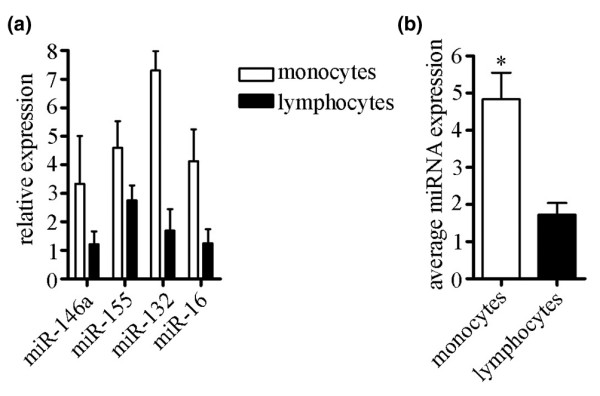
Monocyte/macrophage fraction of PBMCs exhibit increased miRNA expression compared with lymphocyte fraction. PBMCs were collected from RA patients and separated into monocyte/macrophage and lymphocyte populations by allowing the monocytes/macrophages to adhere to a tissue culture dish. (a) miRNA expression was examined using qRT-PCR. SEM is shown (n = 2 patients). (b) Average expression levels of miR-146a, miR-155, miR-132, and miR-16 are shown for monocyte and lymphocyte populations for two RA patients. *P < 0.02, as determined by Mann-Whitney test. SEM is shown. PBMC, peripheral blood mononuclear cell; qRT-PCR, quantitative real-time RT-PCR; RA, rheumatoid arthritis; RT-PCR, reverse transcription polymerase chain reaction; SEM, standard error of the mean.